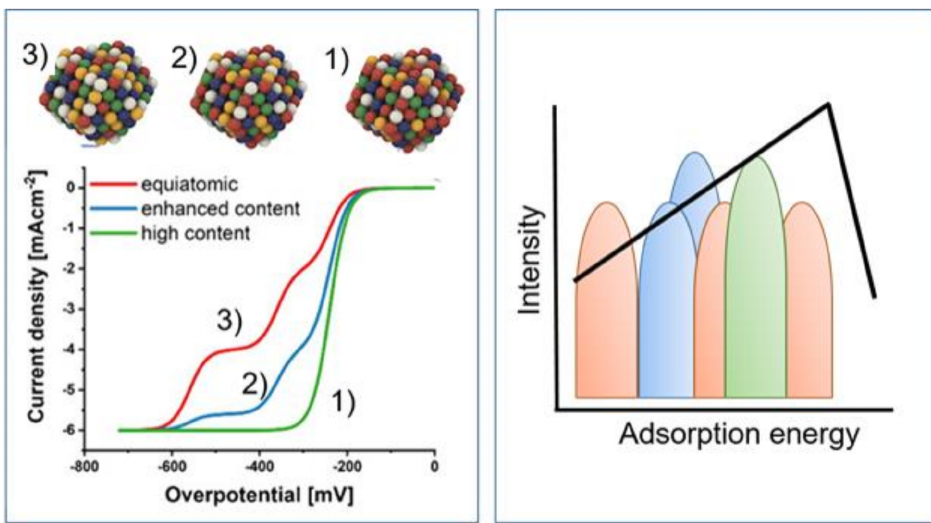
Figure 4. Left: Model representation of three different HEA with a high content of one element (1), enhanced content of one element (2), and equiatomic (3) compositions along with the polarization curves. Right: Adsorption energy distribution patterns for the three different materials (1), (2), and (3), respectively. Adapted with permission from [144]. Copyright © 2021, American Chemical